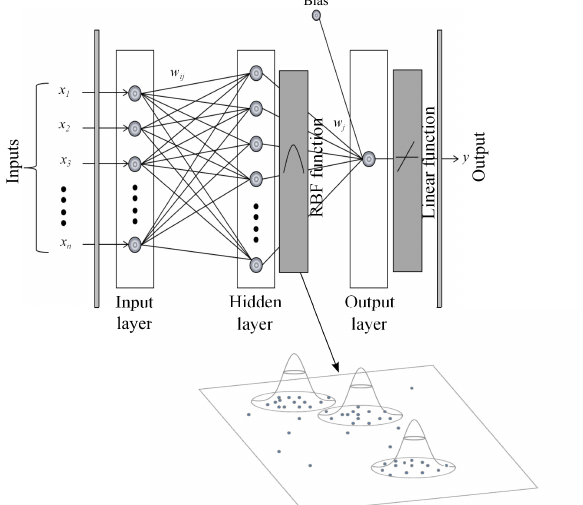
Figure 5. Topology of radial basis function (RBF) neural